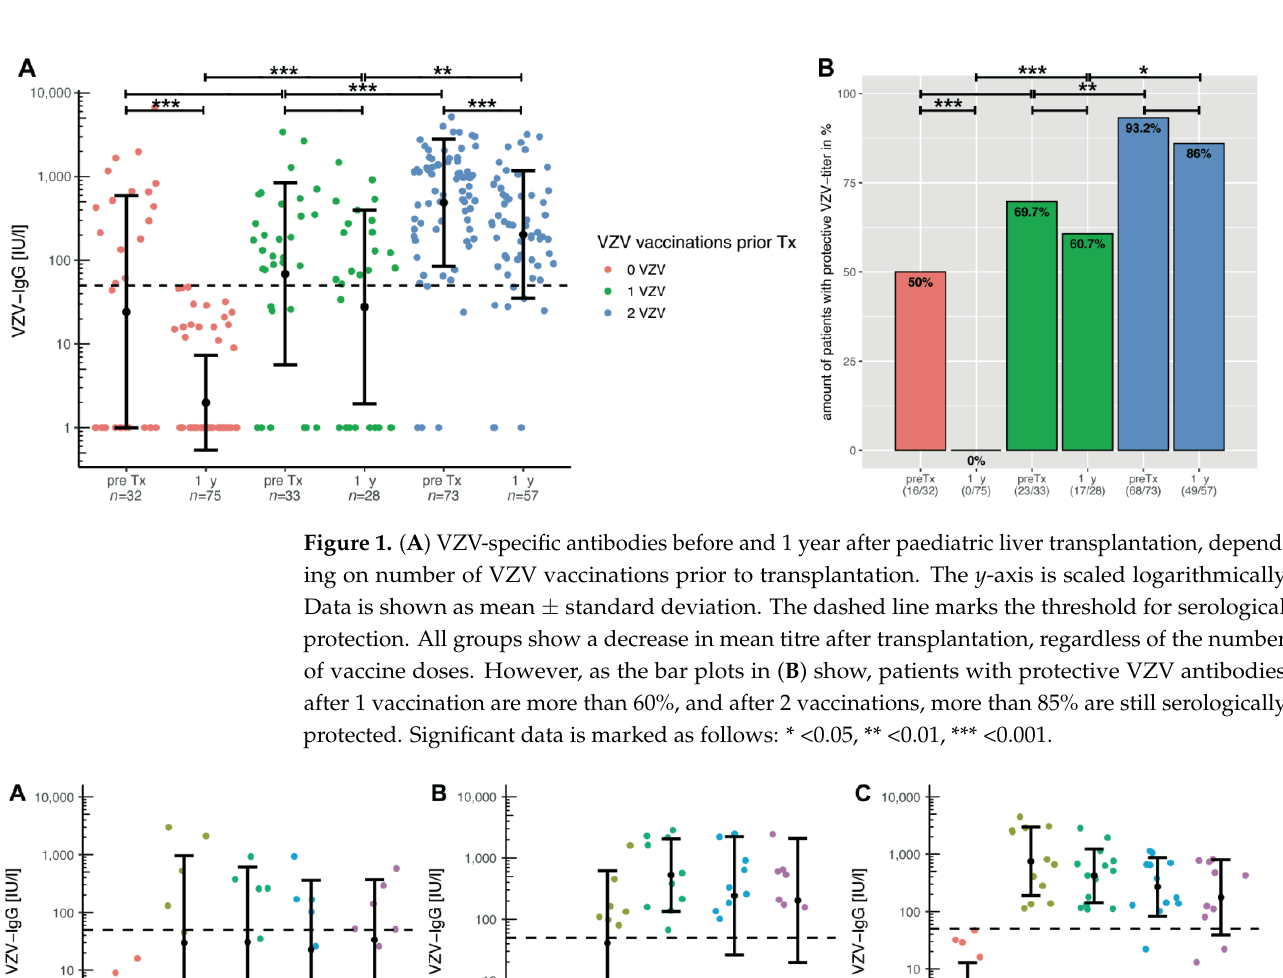
Figure 2. VZV-specific antibody responses following VZV-vaccination in VZV-naïve paediatric liver transplant recipients immunized for the first time 1 year after transplantation. Titre levels over 4 years, following ( A ) one dose after 1 year, ( B ) one dose after 1 and 2 years, and ( C ) two doses after 1 year. The y -axis is scaled logarithmically. Data is shown as mean ± standard deviation. The dashed line marks the threshold of serological protective titres.